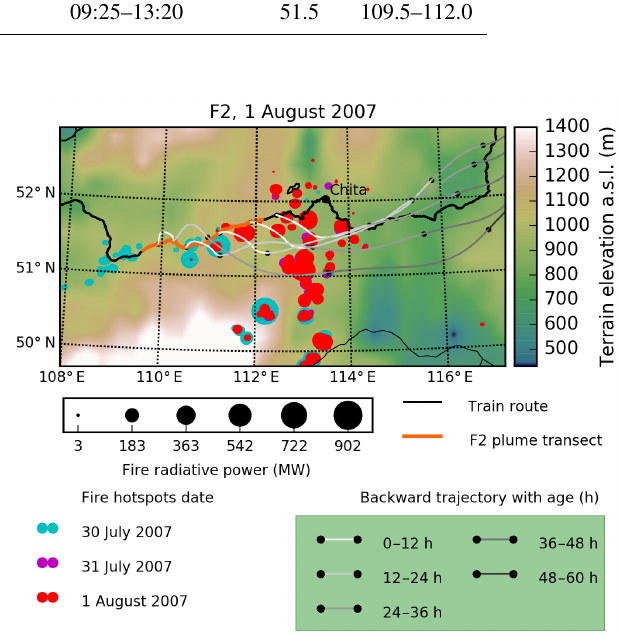
Figure 1. Map of the train route with the F1 plume transect loca- tion. The train course is from west to east. Circles show active fires detected by the MODIS satellite during the day of plume observa- tion and 2 days before that and are colored by date and sized by fire radiative power (FRP). Gray lines with open markers show the en- sembles of HYSPLIT model backward air parcel trajectories started with hourly time increments along the train route within the plume and the time stamps coded by the number of hours before arrival of an air parcel at the point of observation. Chita is a town with a population of 343511 (Russian Government Statistical Service, 2016).